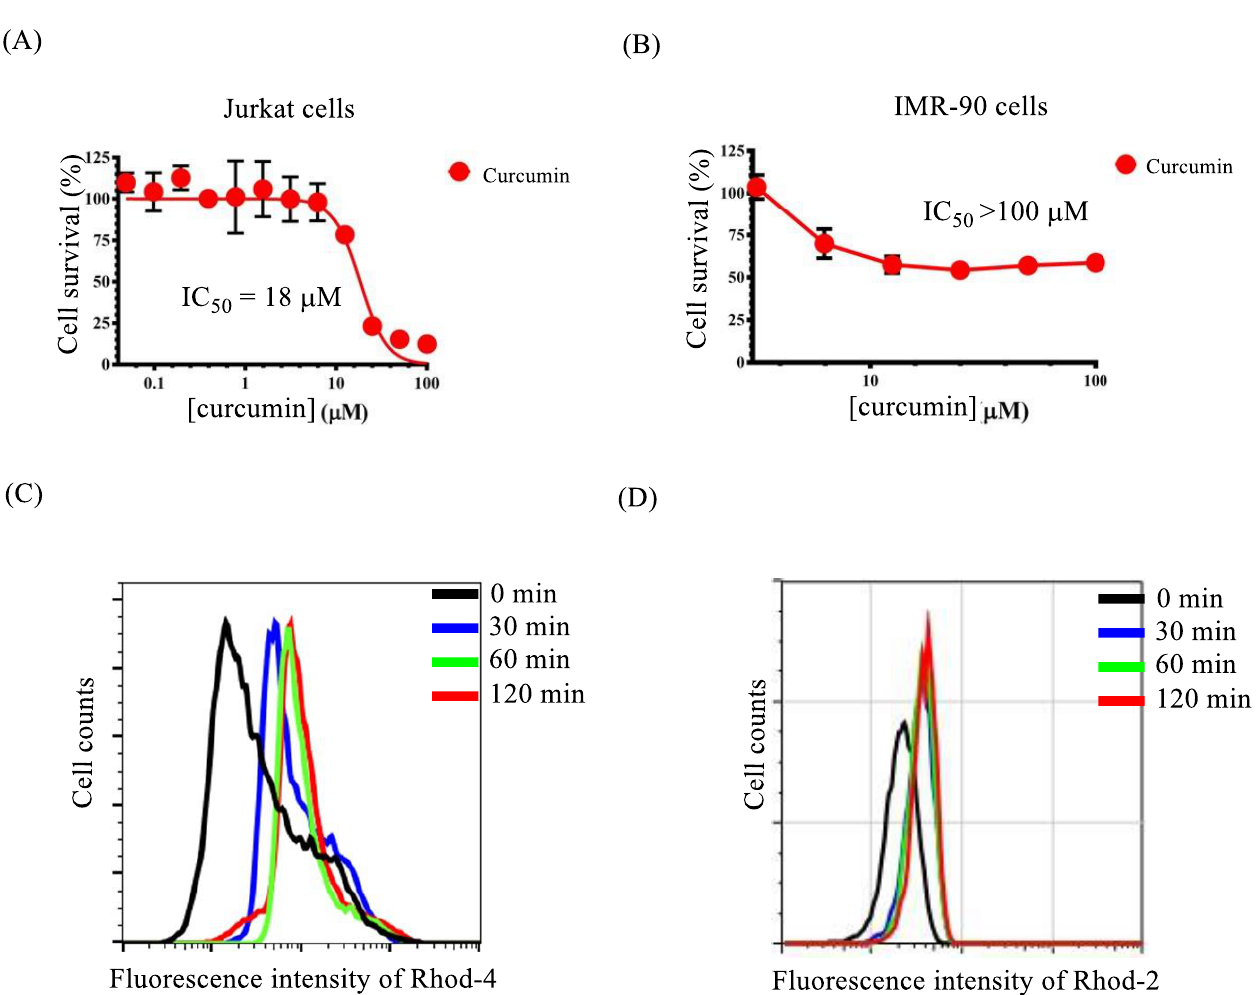
Figure 9. ( A ) The results of MTT assays of Jurkat cells treated with curcumin for 24 h at 37 °C. ( B ) The results of MTT assays of IMR-90 cells treated with curcumin for 24 h at 37 °C. ( C ) Flow cytometry analysis of Jurkat cells treated with curcumin (50 µM) and then stained with Rhod-4/AM (5 µM) for 30, 60, and 120 min at 37 °C. ( D ) Flow cytometry analysis of Jurkat cells treated with curcumin (50 µM) and then stained with Rhod-2/AM (5 µM) for 30, 60, and 120 min at 37 °C.